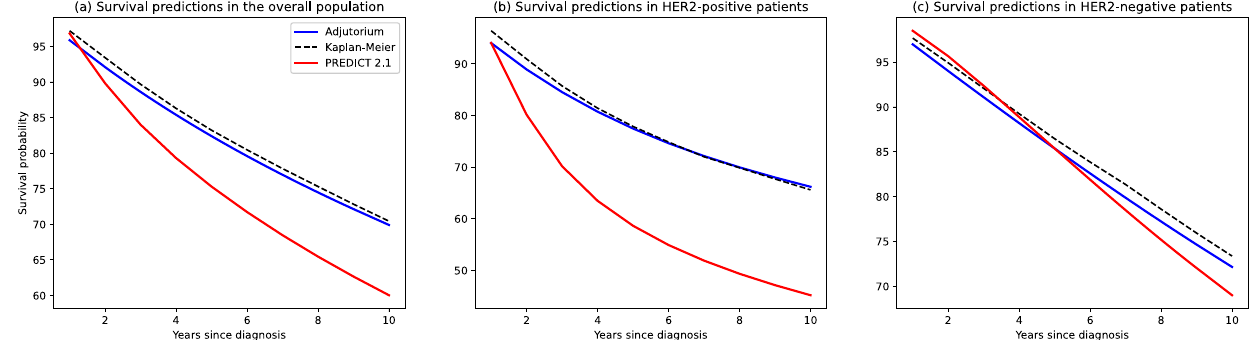
Fig. 1 Comparison between the average survival predictions issued by Adjutorium and PREDICT. a – c The predicted survival curves by the two models for the overall population, the HER2-positive and HER2-negative subtypes, respectively. The average survival curve predicted by Adjutorium is colored in blue, whereas the survival curve issued by PREDICT is colored in red. The empirical Kaplan – Meier survival curves are depicted through the dashed black lines. These evaluations were conducted using the NCRAS registry data by computing the predicted survival curve issued by the two models for each patient and averaging over the